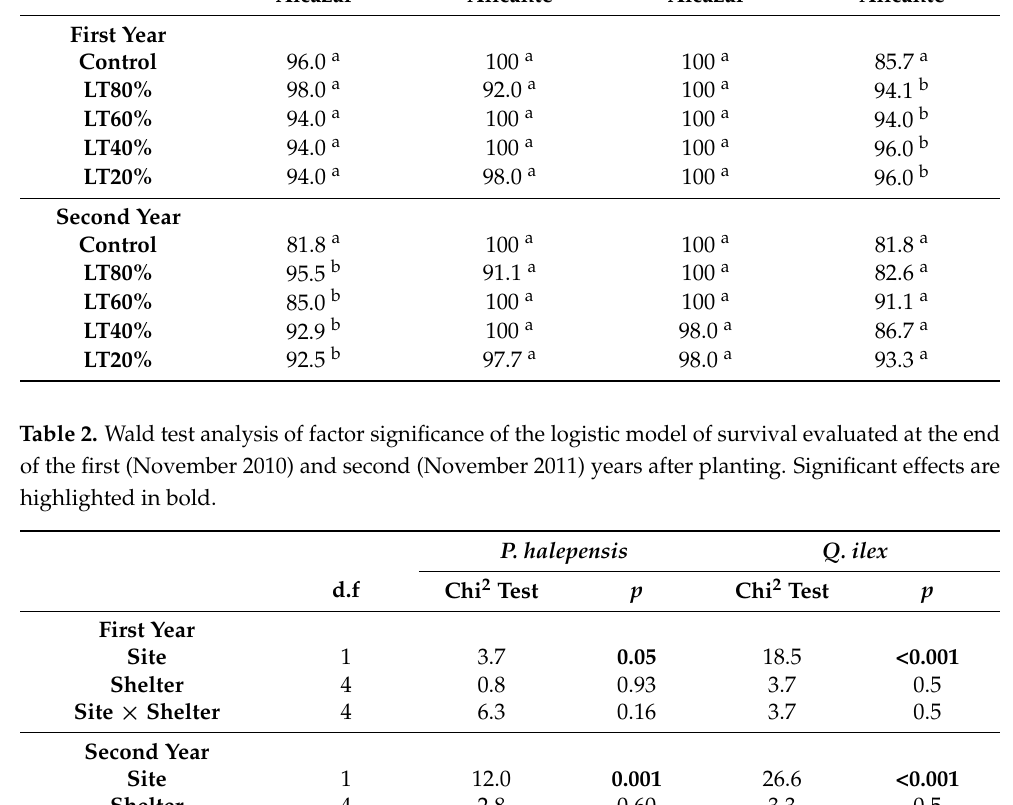
Table 1. Survival rates (%, n = 50) in both planting sites at the end of the first (November 2010) and second (November 2011) years after planting for the different shelter types (control mesh plus a gradient of wall light transmissivity ranging from 20 to 80% of incident radiation). Different letters following survival values denote distinct groups in percentage values within the same year and species across the two different sites (binomial model Tukey post hoc analysis, α = 0.05). Pinus halepensis Quercus ilex Treatment Alc á zar